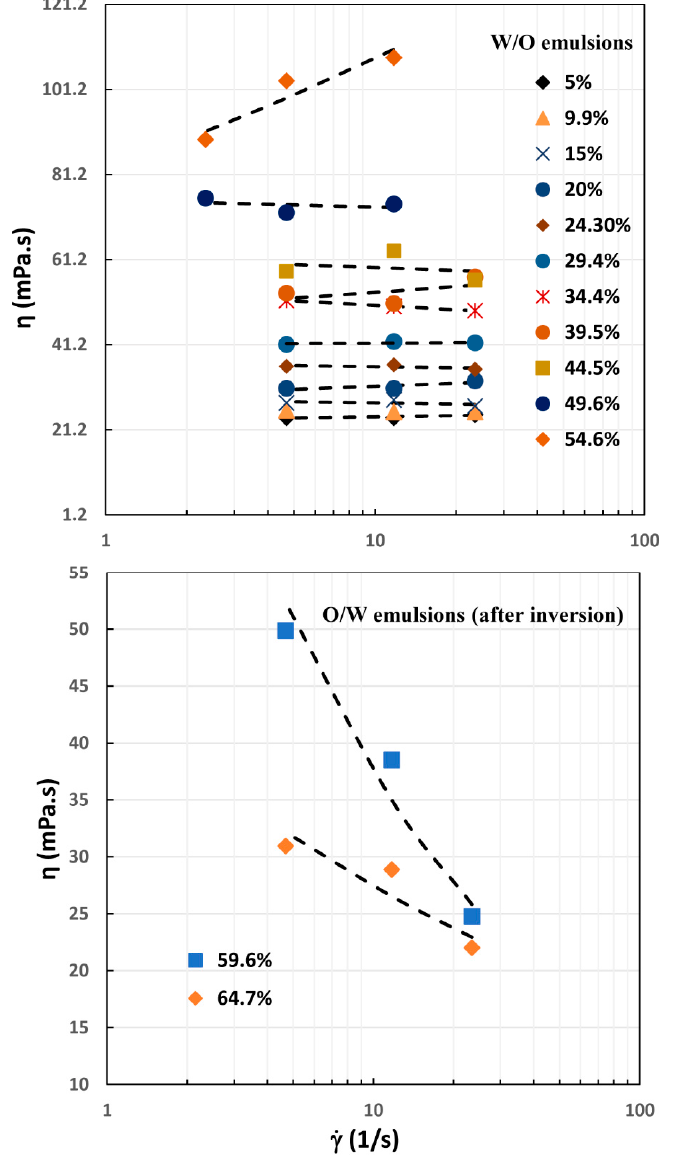
Figure 6. Flow behavior of emulsions with SNP concentration of 1.0% wt. in the aqueous phase. The dashed lines are shown as a guide to the eye. The percent concentrations indicated on the figure are volume percent of aqueous phase.